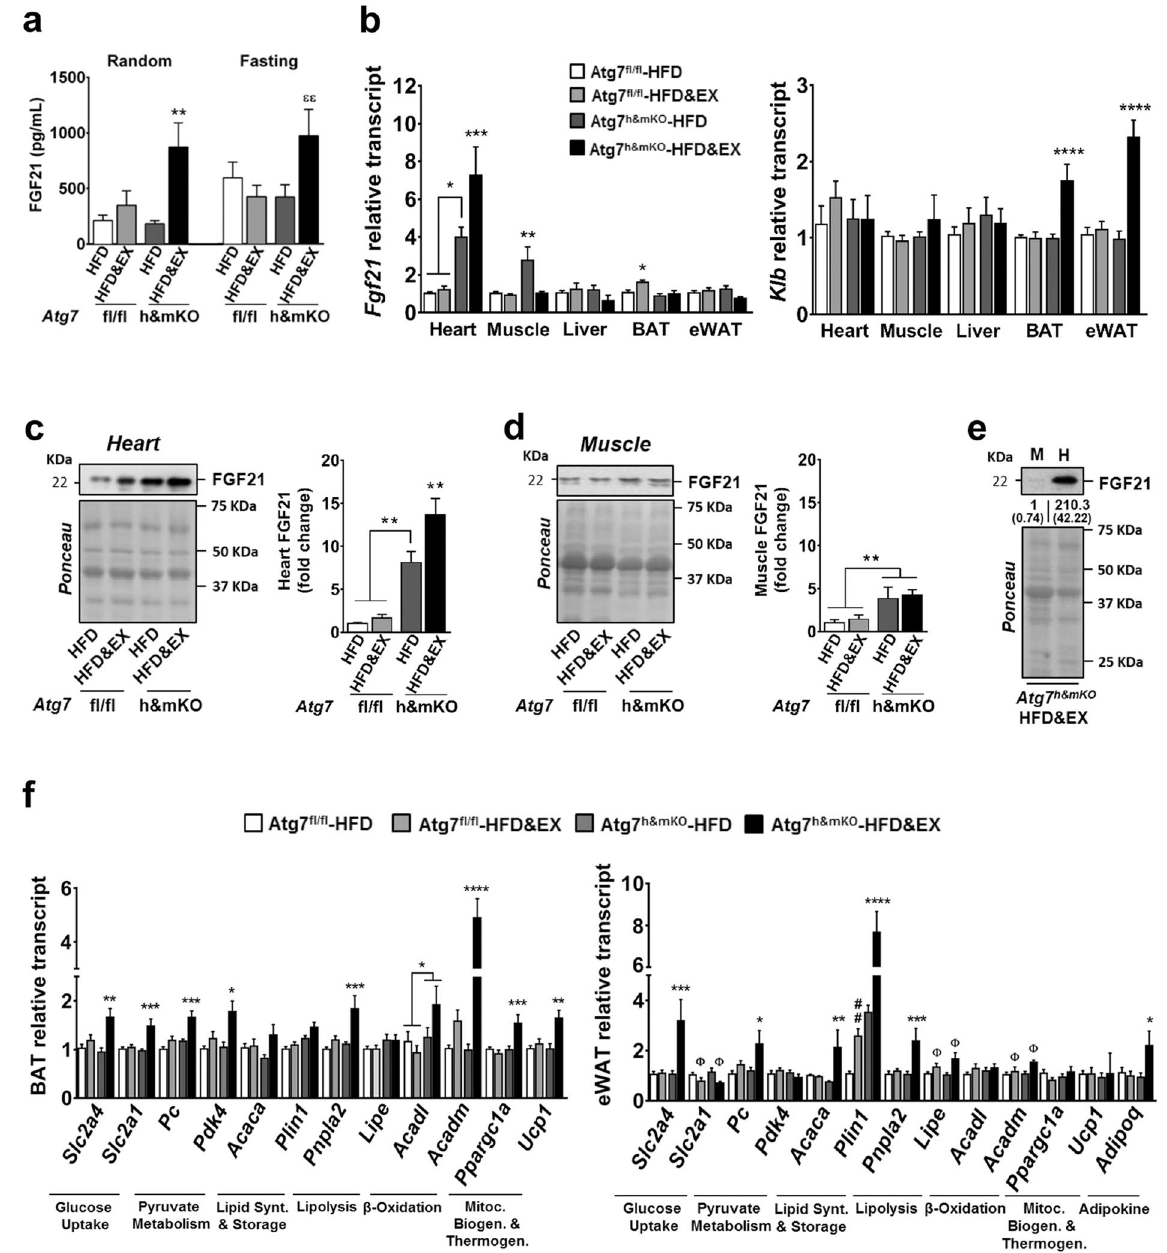
Figure 3. Elevated circulating FGF21 and associated BAT and eWAT metabolic gene profile in exercise-trained Atg7 h&mKO mice. ( a ) Circulating FGF21 under random feeding and overnight fasting conditions (n = 5–7). ( b ) tissue-specific mRNA analysis of Fgf21 and Klb (n = 5–10). ( c ) Immunoblot representative images of the mean value and related quantification of cardiac FGF21 (n = 5). ( d ) Immunoblot representative images of the mean value and related quantification of gastrocnemius skeletal muscle FGF21 (n = 5). ( e ) Immunoblot representative images of the mean value and related quantification of muscle (M) vs. heart (H) FGF21 levels in exercise-trained Atg7 h&mKO mice (n = 3). ( f ) mRNA analysis of select metabolic genes in BAT and eWAT (n = 6–10). Full- length blots are presented in Supplementary Fig. S4. * P < 0.05, ** P < 0.01, *** P < 0.001, **** P < 0.0001 in comparison to all other groups, unless otherwise represented; ## P < 0.01 in comparison to Atg7 fl/fl -HFD; and Φ P < 0.05 denotes a significant effect of exercise in both Atg7 fl/fl and Atg7 h&mKO ; and εε P < 0.01 in comparison to Atg7 h&mKO -HFD and Atg7 fl/fl -HFD&EX